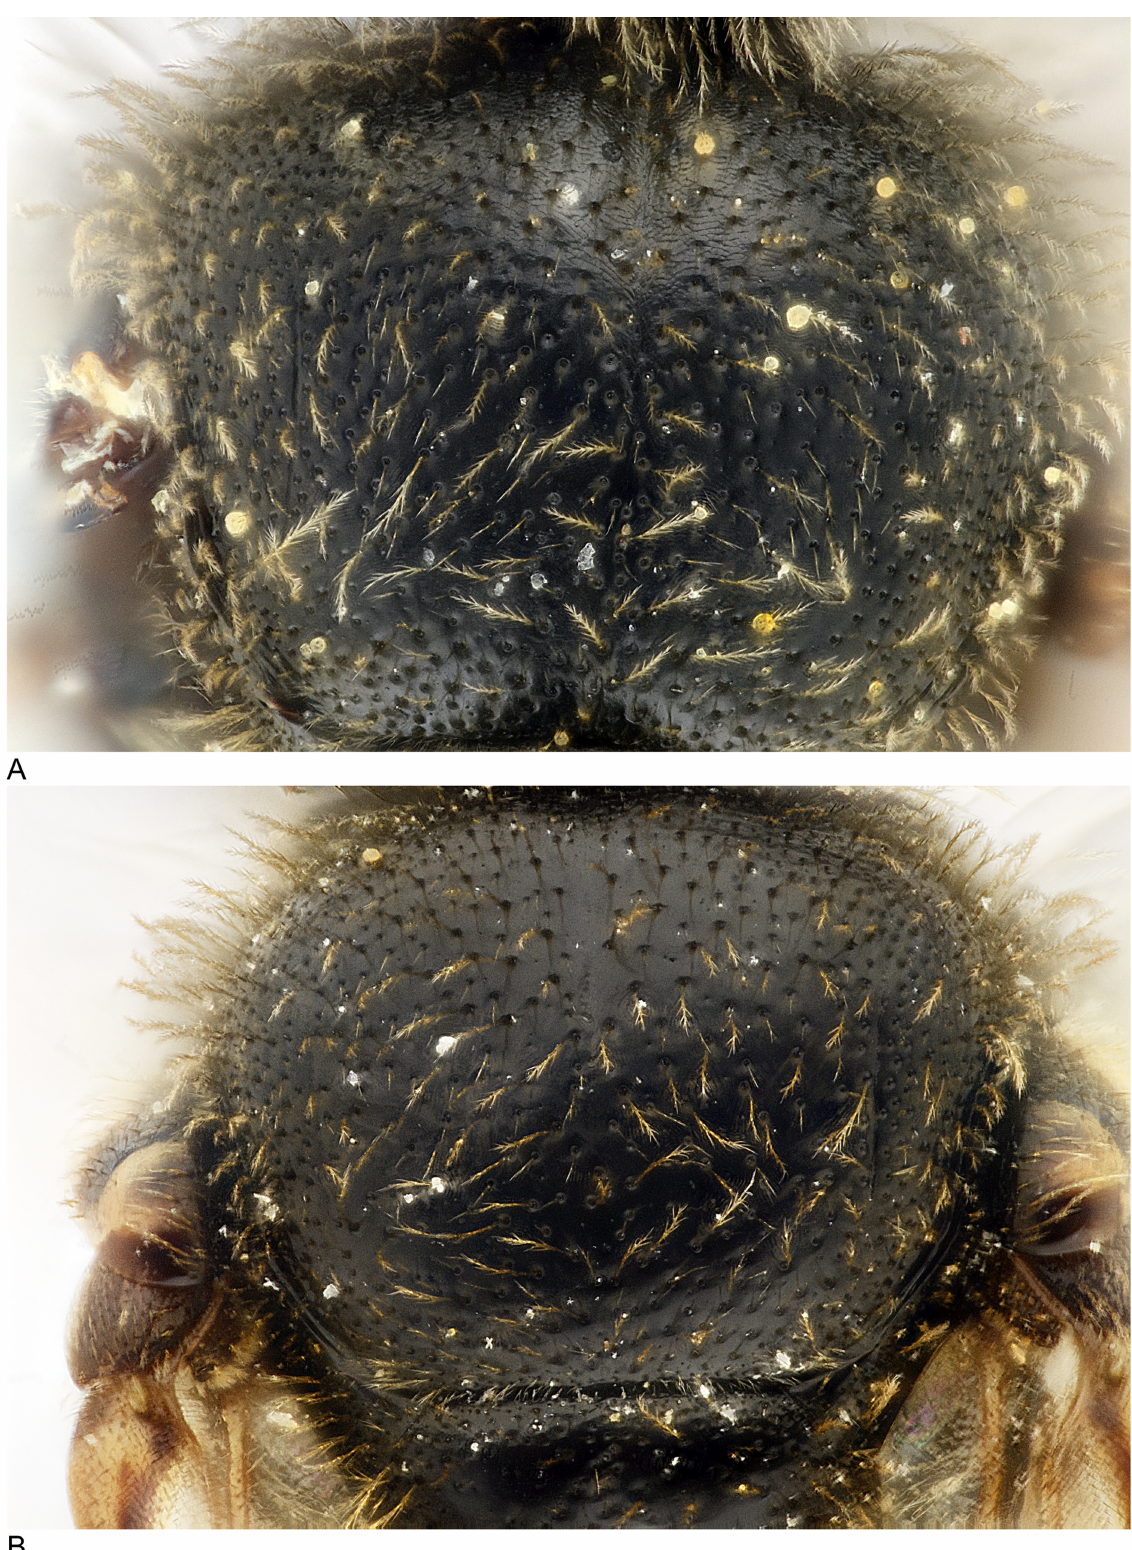
Fig. 16. Punctation of the scutum of females. A . Lasioglossum medinai (Vachal, 1895) (France: Uchaux). B . L. villosulum (Kirby, 1802) (Belgium: